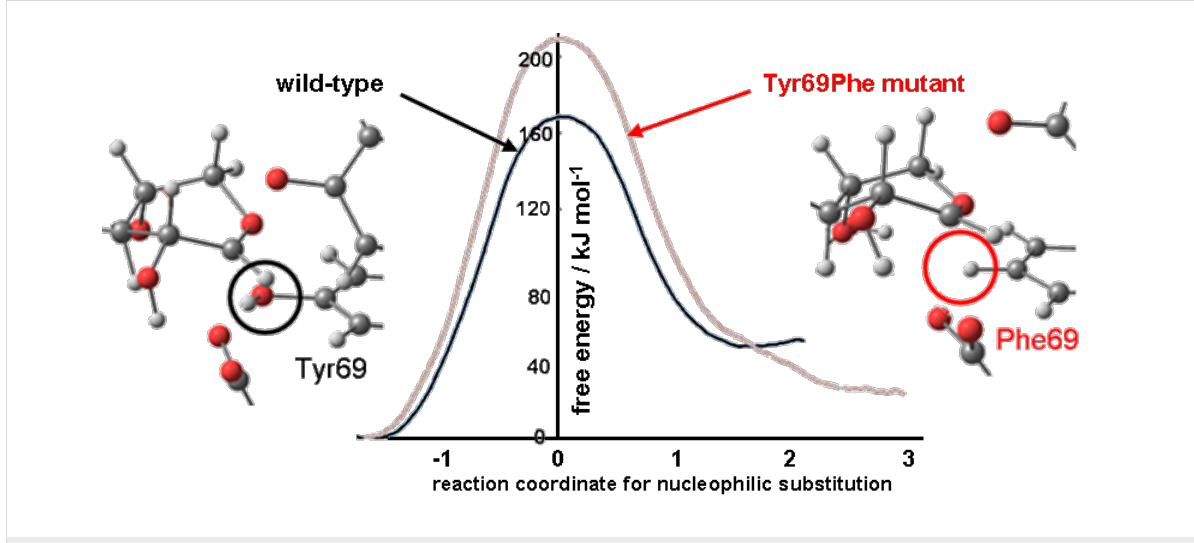
Figure 6: AM1/OPLS potentials of mean force for formation of glycosyl-enzyme covalent intermediate between 4-nitrophenylxylobioside and BCX wild-type (black) and Tyr69Phe mutant (red).